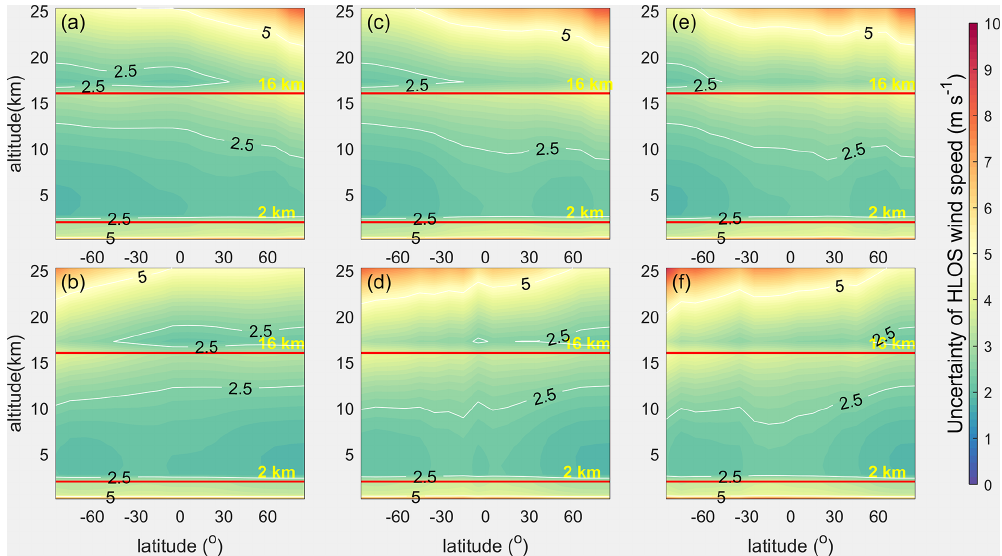
Figure 5. The zonal distributions of the Rayleigh channel wind uncertainties in clear air conditions observed by the three spaceborne DWLs operating on the three orbits of which the instrument parameters are the same as those of Aeolus. The contours show the accuracy requirements of ESA. The arrangement of the subgraphs corresponds to that of Fig.